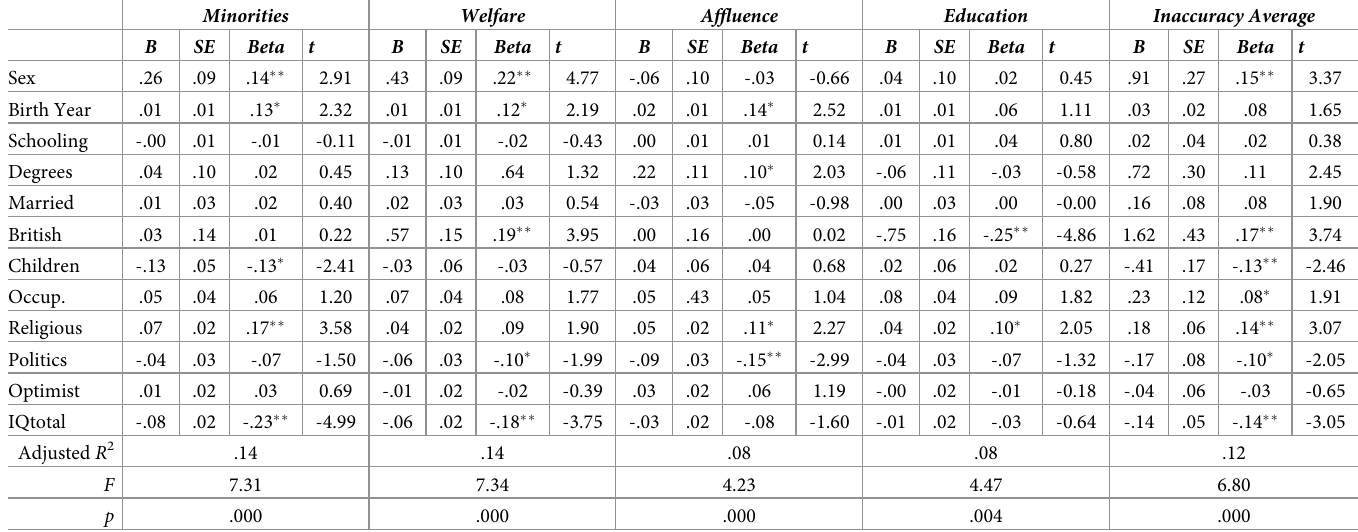
Table 5. Regressions onto four factors and average